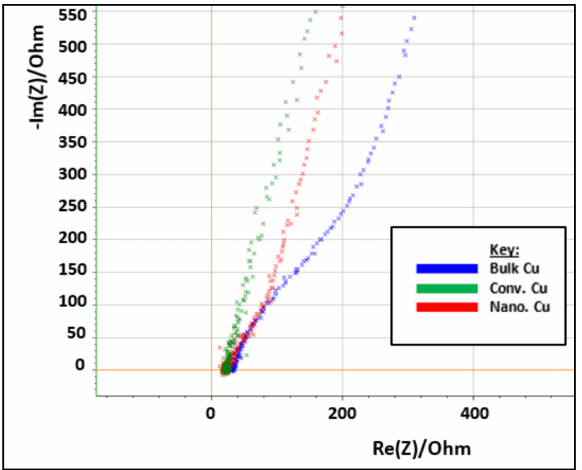
Figure 25. Electrochemical impedance spectroscopy for the nanostructured Cu coating, the conventional Cu coating and bulk / wrought